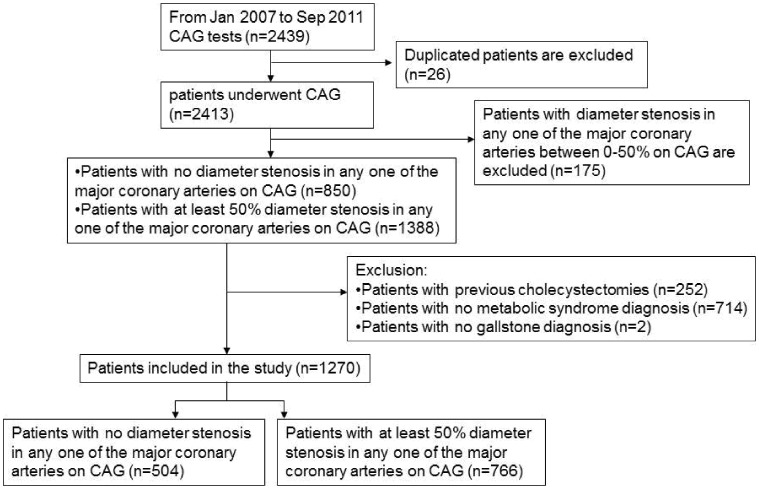
Study recruitment and participant flow.There were 2,413 patients who underwent coronary angiography for the first time included in the study. The final number of patients was 1,270 (766 in the CAD-positive and 504 in the CAD-negative group, respectively).